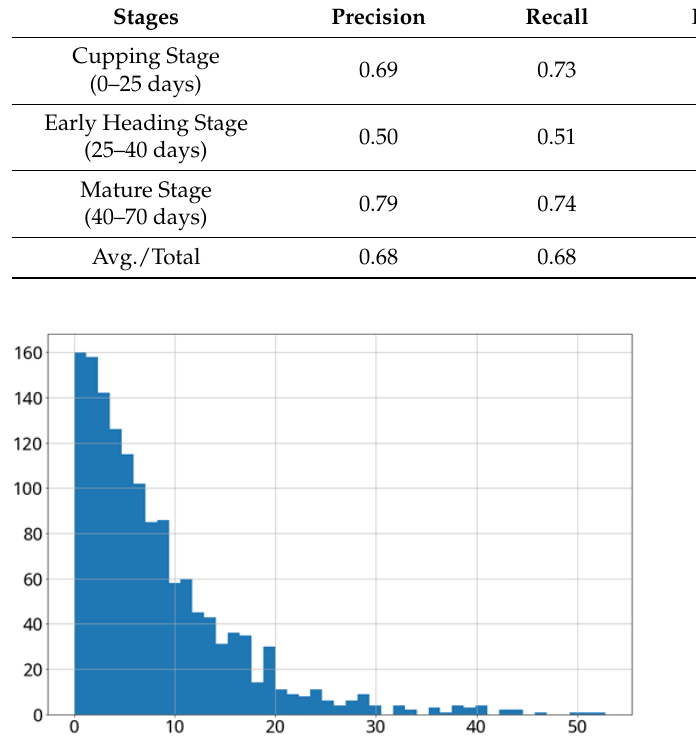
Figure 23. Distribution chart of the growth stage prediction of cabbage.